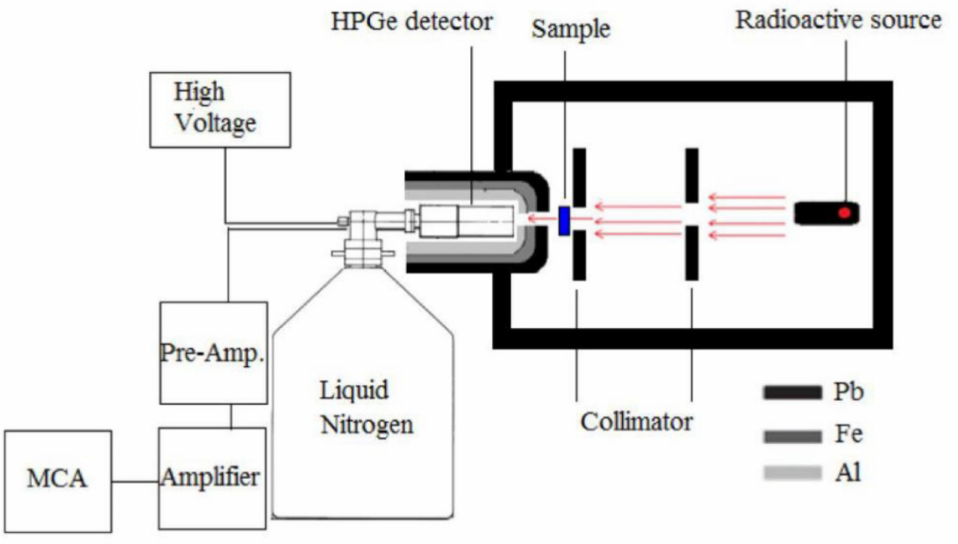
Figure 3. Narrow beam transmission geometry for experimental mass attenuation coefficient